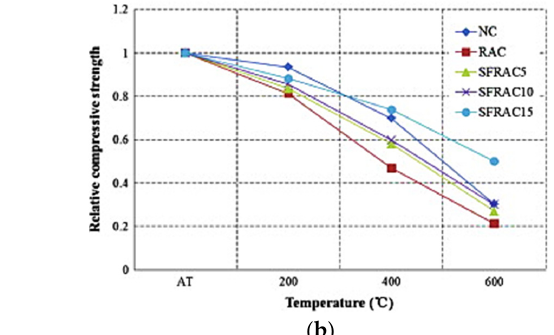
Figure 11. Variations in residual compressive strength of conventional and polypropylene-rein- forced concrete with rising temperature, where L denotes the length of polypropylene fiber, i.e., 6